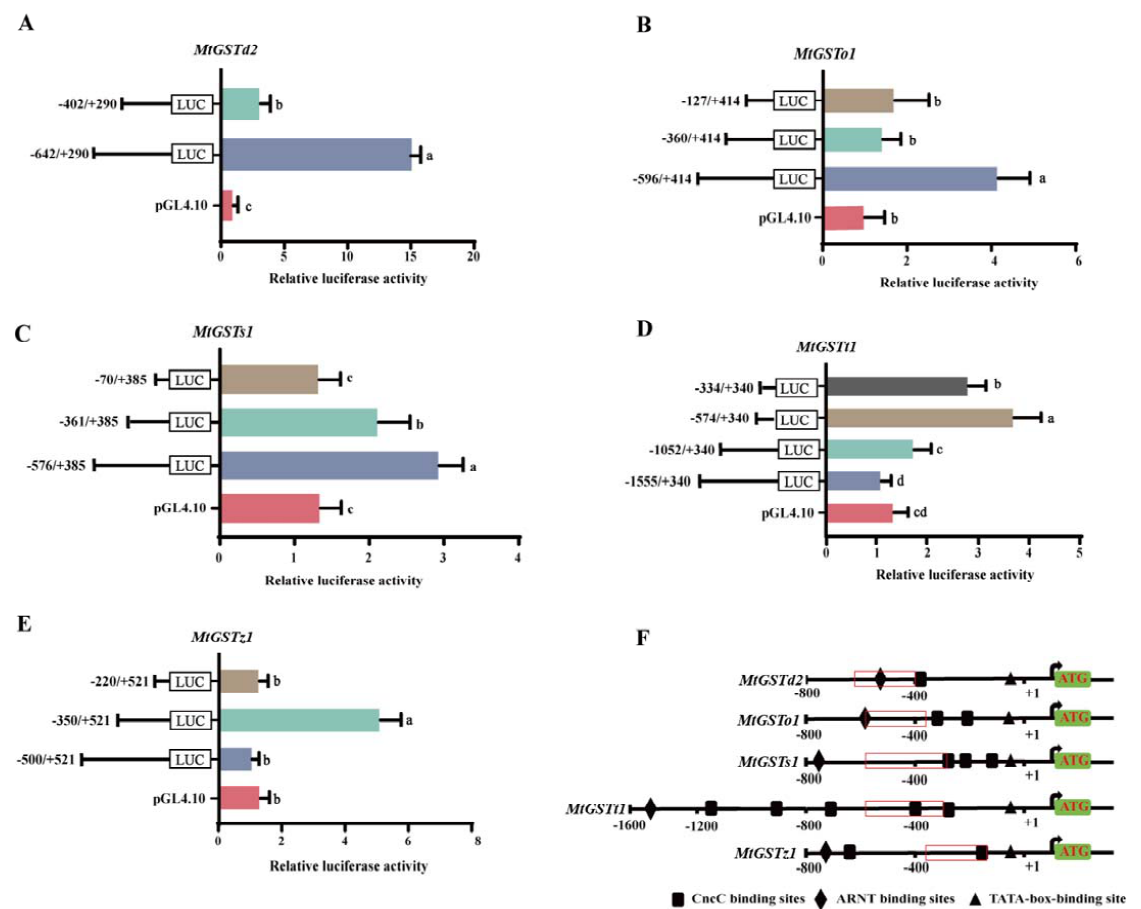
Figure 1. Relative luciferase activities of the 5 ′ loss fragment of MtGST promoters. ( A ): MtGSTd2 promoter constructs; ( B ): MtGSTo1 promoter constructs; ( C ): MtGSTs1 promoter constructs; ( D ): MtGSTt1 promoter constructs; ( E ): MtGSTz1 promoter constructs; F: Prediction analysis of the promoter regions of five MtGST genes. Each value is presented as the mean ± SD of three replicates, and different lowercase letters show significant differences ( P < 0.05). ( F ): The core regions deduced from five MtGST promoters. The location of nucleotides was marked relative to the transcription start site indicated by +1 and the translation start site indicated by ATG. The red box represents the core region of each promoter. The pGL4.10-( − 642/+290) vector of MtGSTd2 promoter had relatively high luciferase expression compared with that of pGL4.10-( − 402/+290), which showed that sequences were essential for the transcription of MtGSTd2 located in the 240 bp region between − 642 and − 402 bp (Figure 1A). The pGL4.10-( − 596/+414) vector of MtGSTo1 promoter exhibited relatively high luciferase expression compared with that of pGL4.10-( − 360/+414) and pGL4.10-( − 127/+414), which suggested that − 596 to − 360 region was critical for MtGSTo1